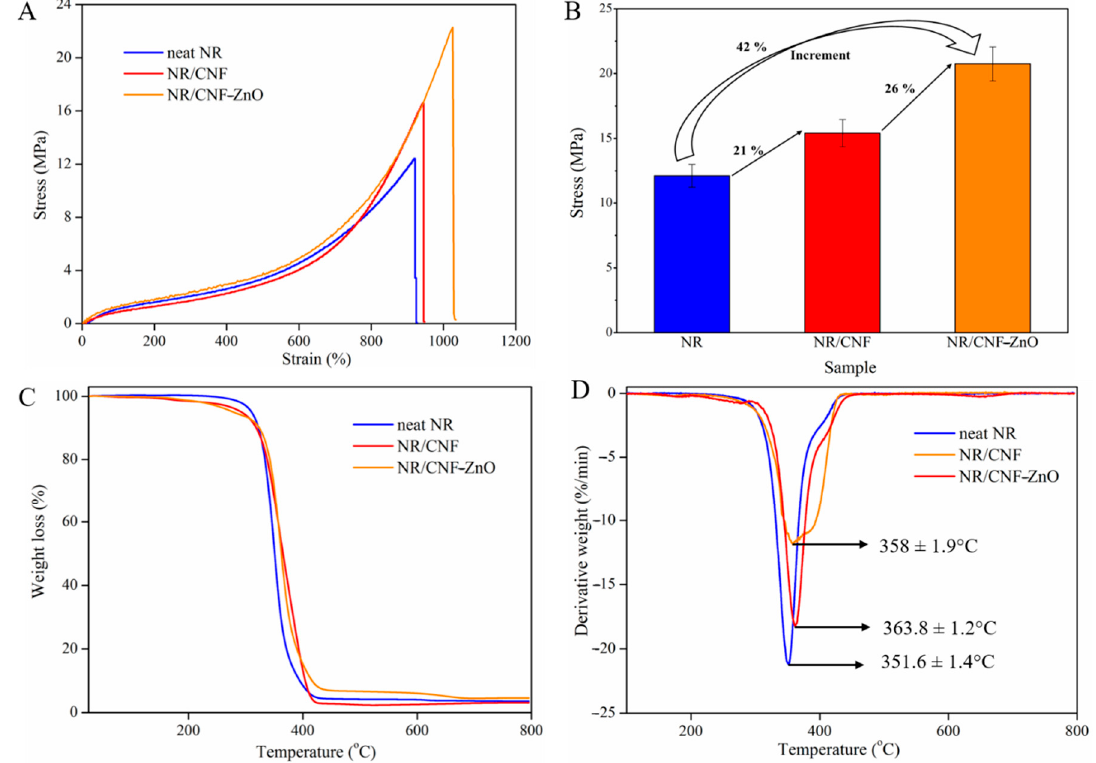
Figure 7. ( A ) Stress–strain curves; ( B ) Tensile strength increment; ( C ) TGA analysis; and ( D ) DTG curves of the neat NR, NR/CNF, and NR/CNF-ZnO composites.